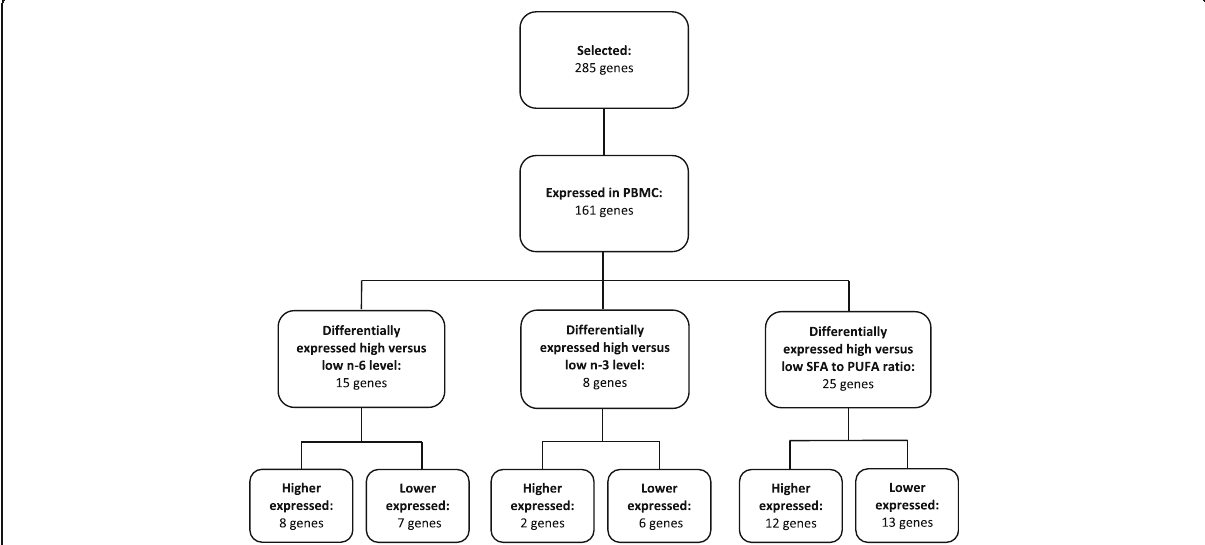
Fig. 1 Flowchart of gene selection and number of differentially expressed genes between subjects in the highest and lowest tertile of plasma n-6 level, plasma n-3 level and plasma SFA to PUFA ratio. Differences in Log2 gene expression between subjects in the highest and lowest tertiles were compared by independent samples t test. P values <0.05 were considered